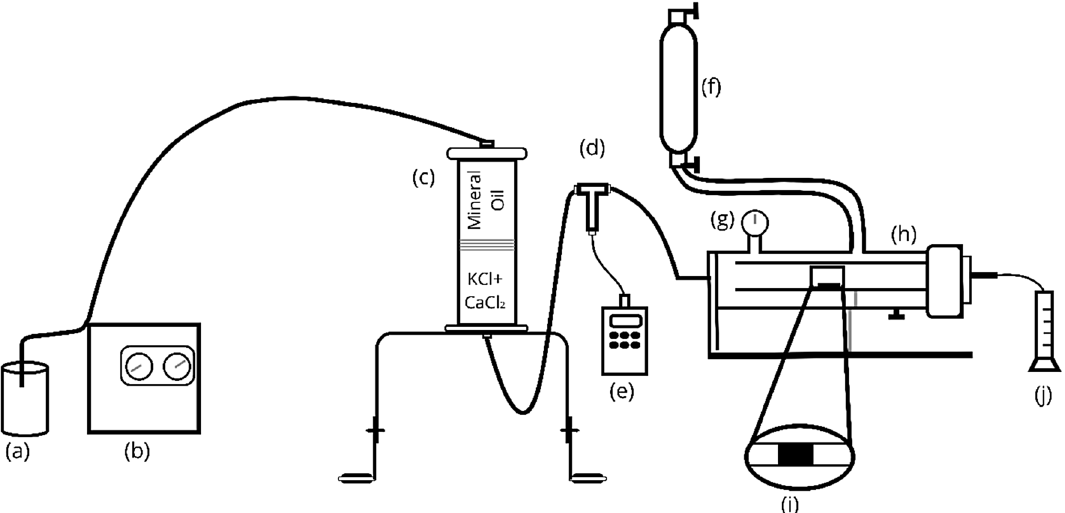
Fig. 1 Fluid injection system: (a) mineral oil reservoir; (b) positive displacement pump; (c) injection cell; (d) and (e) pressure socket and pres- sure gauge; (f) source of compressed air; (g) holder manometer; (h) holder; (i) plug; (j) test